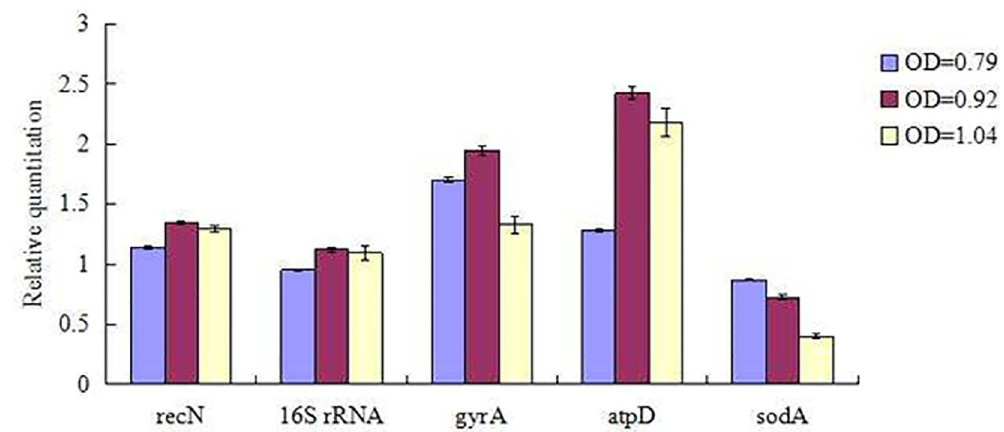
Fig 2. 50S ribosomal protein L33 expression analysis at different time points in stationary phase in cultures of serovarB of A . paragallinarum . Different colored columns show the relativequantificationof 50S ribosomal protein L33 when normalizedagainstreference genesat three samplingtime points. RecN and 16S rRNA were the two highestranked genes, gyrA and atpD were the two highlyranked genes for cultures of serovar B of A . paragallinarum in stationary phaseand sodA was a poorly